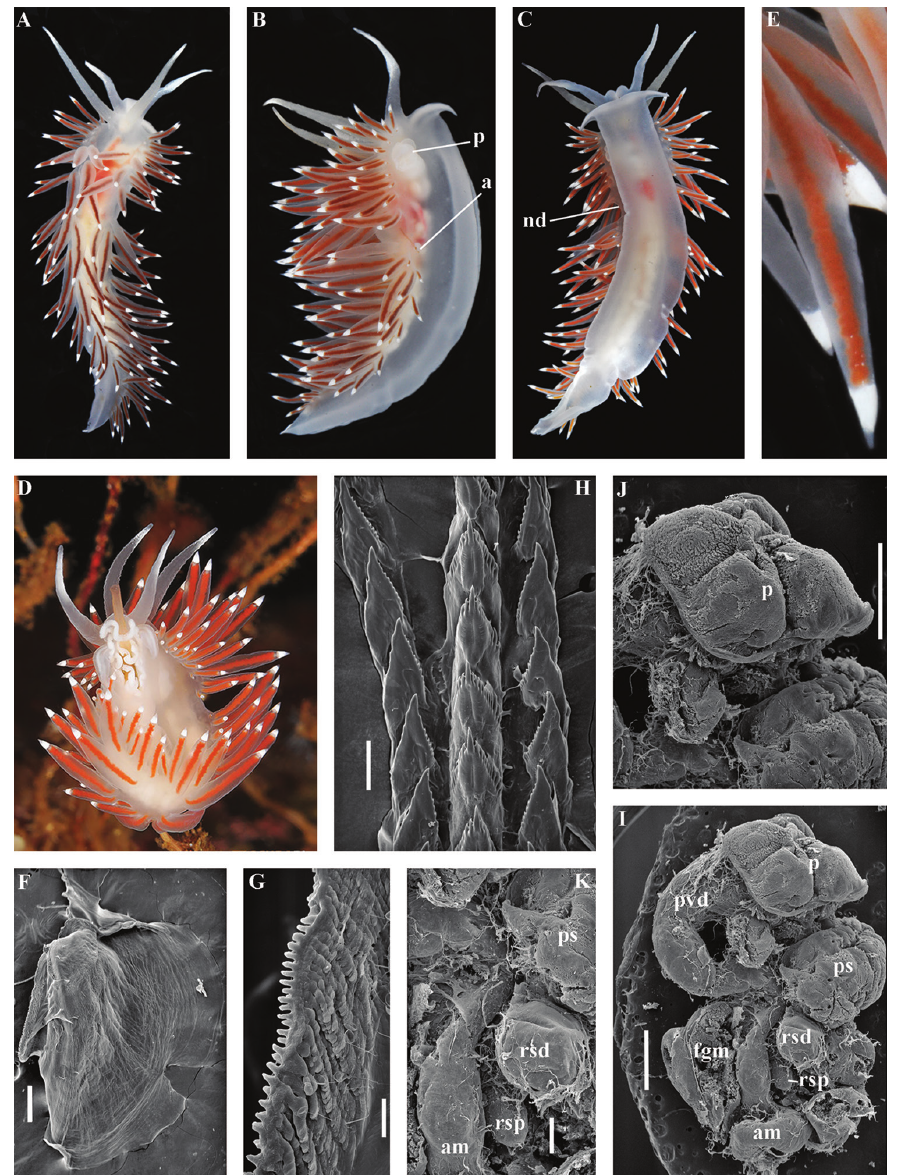
Figure 22. Fjordia browni (Picton, 1980), comb. n. Norwegian Sea, Gulen Dive Center. ZMMU Op- 413, living specimen 48 mm in length: A dorsal view B lateral view C ventral view D living specimen on hydroid colony E details of cerata F jaw, SEM G details of masticatory process of jaw, SEM H radular teeth, posterior part, SEM I reproductive system, SEM J penis, SEM K seminal reservoirs. Abbreviations: a anus am ampulla rsd distal receptaculum seminis fgm female gland mass nd discontinuous notal edge p penis ps penial sheath pvd prostatic vas deferens rsp proximal receptaculum seminis. Scale bars: F, J, K = 300 μm; G = 30 μm; H = 100 μm; I = 1 mm. Photos of living specimens by T.A. Korshunova ( A–C ), and C. Skauge ( D ), SEM images by A.V.